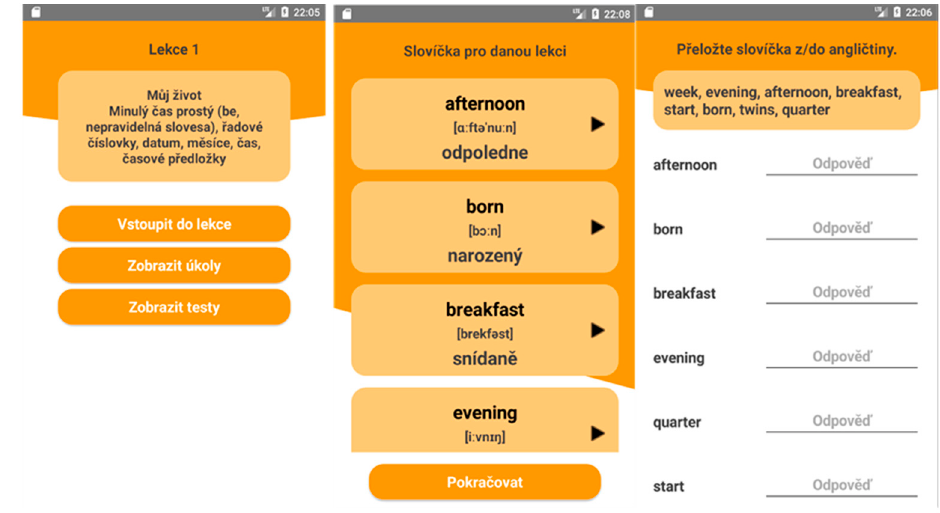
Figure 1. Illustration of Lesson 1 and vocabulary module.